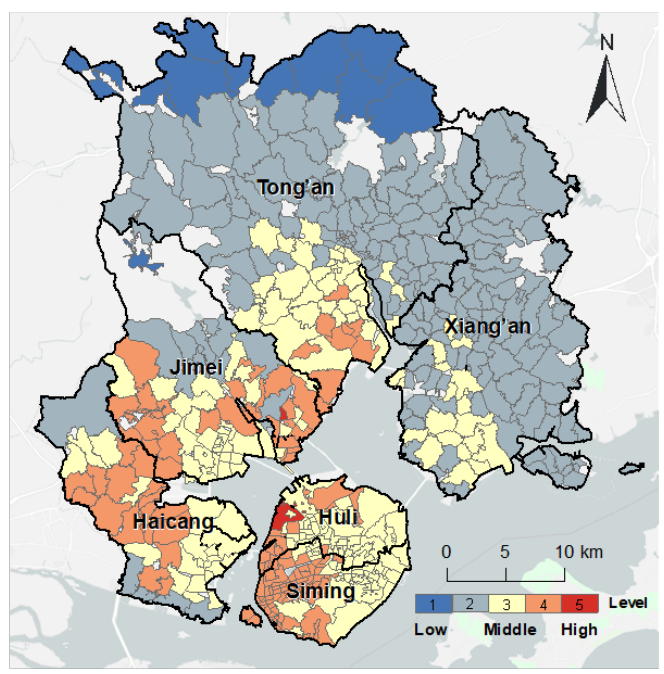
Figure 7. Spatial distribution of accessibility of surgery service in Xiamen City.